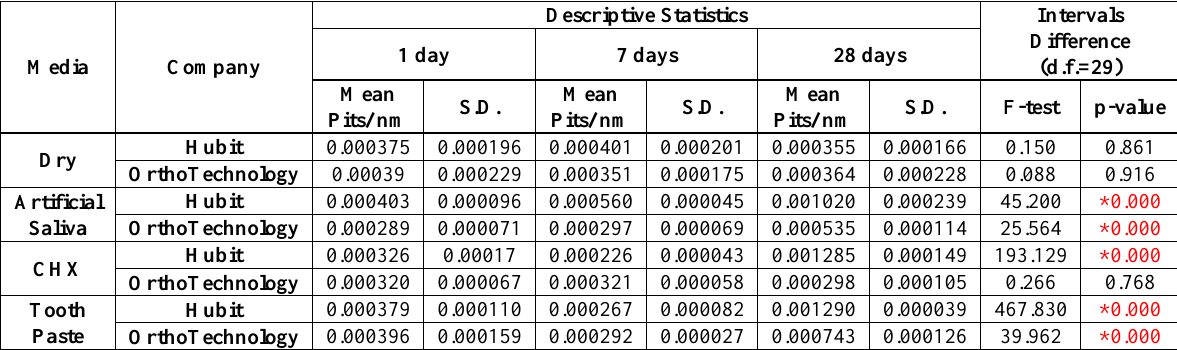
Table 3: The Effect of Time of Immersion in Each Media for Each